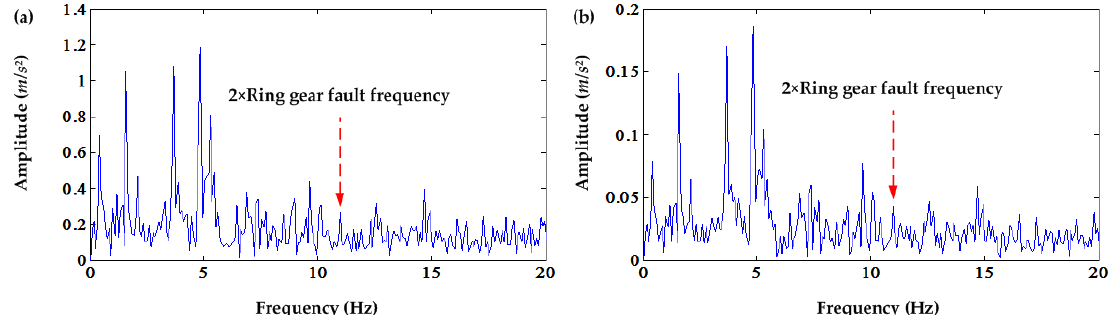
Figure 27. ( a ) Squared envelope spectrum after the first DC offset cancellation; ( b ) the envelope spectrum of the original signal.